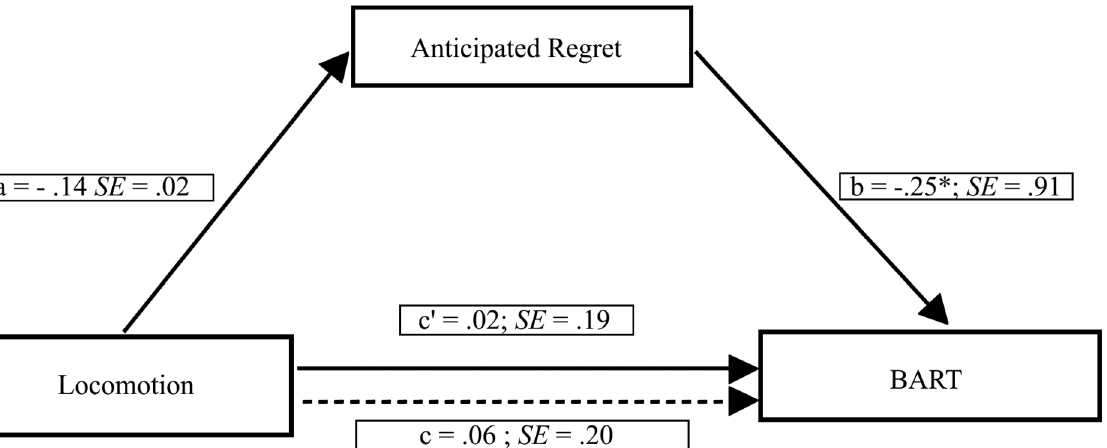
Fig 3. Mediation model showing the effect of the locomotion orientation on risk-taking through anticipated regret. Path values represent standardized regression coefficients. The (c') value represents the effect, from bootstrapping analyses, of the locomotion orientation on risk-taking after the mediator is included. Dotted line (c) represents the effect of the locomotion orientation on risk-taking prior to the inclusion of anticipated regret. * p < .05; ** p < .001.